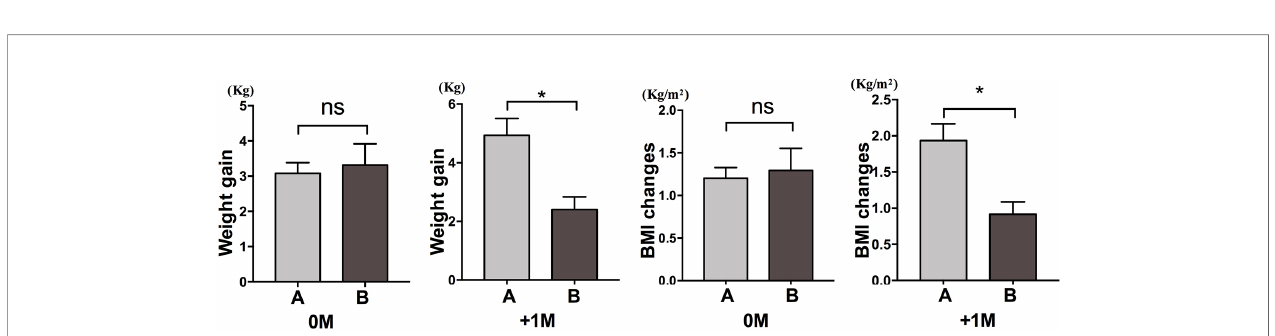
FIGURE 4 | Comparison of weight gain velocity of participants with increased appetite in different months. We compared the weight gain velocity of participants with increased appetite within 4 weeks (A) and participants with an increased appetite between 4 and 8 weeks (B) in the month of time to increased appetite (0M) and 1 month after the month of time to increased appetite (+1M). ns, indicates not signi fi cant, * indicates P <